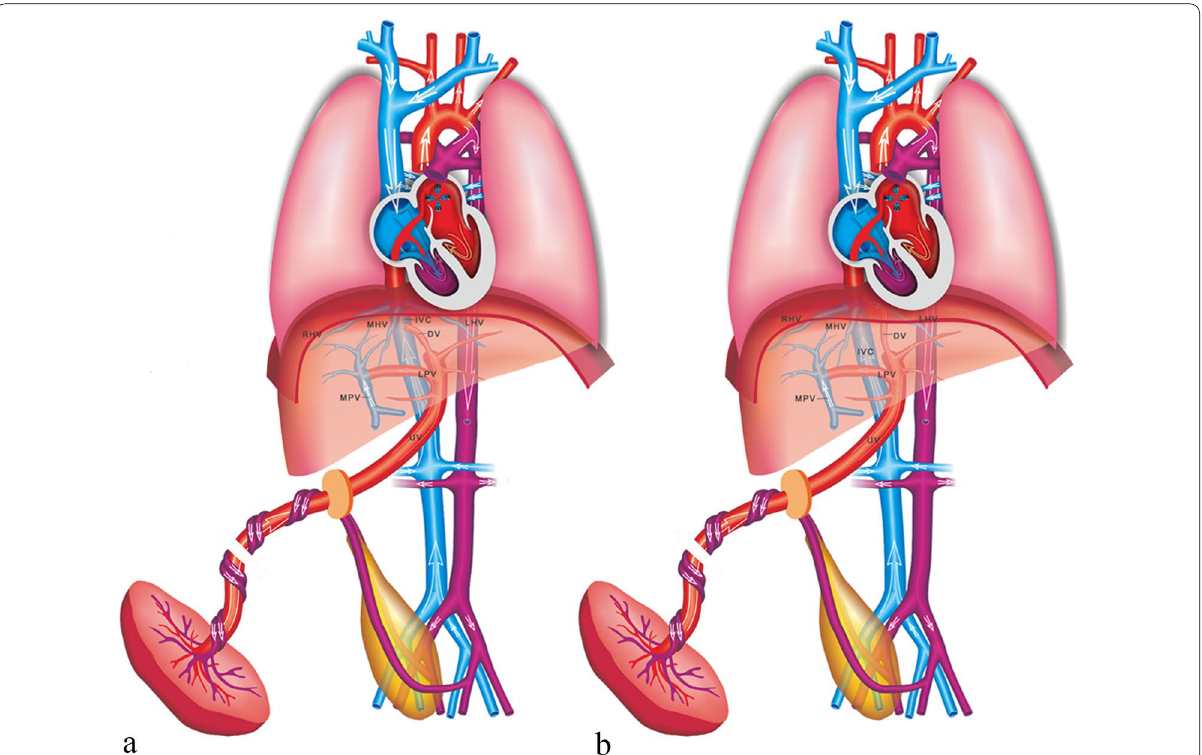
Fig. 16 Schematic drawing of the DVSS. The DV is shunted into the IVC ( a ) and the HV ( b )